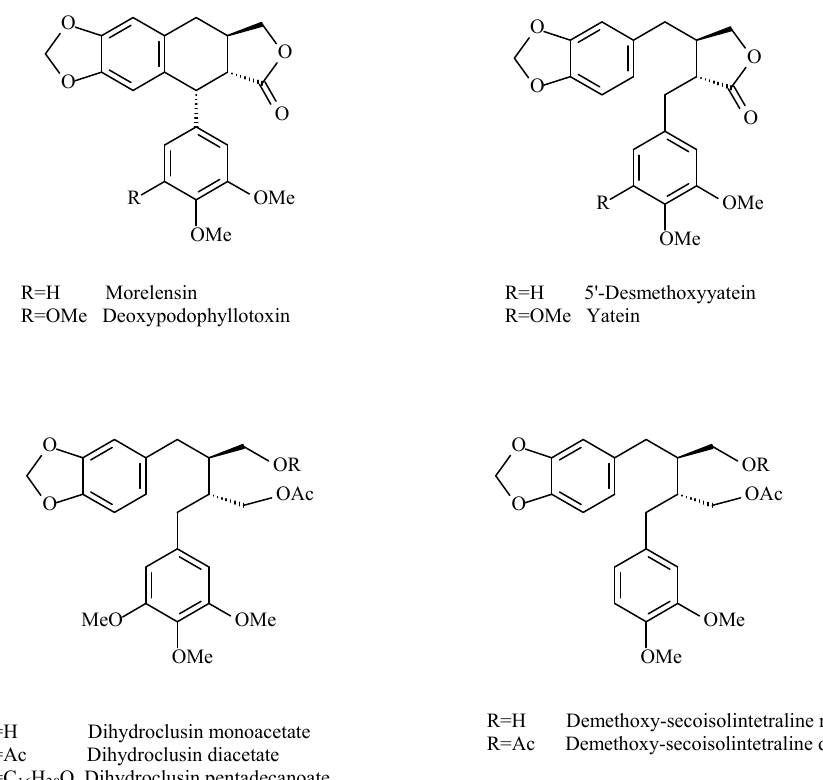
Figure 5. Lignans isolated from B. fagaroides resin [37,38].